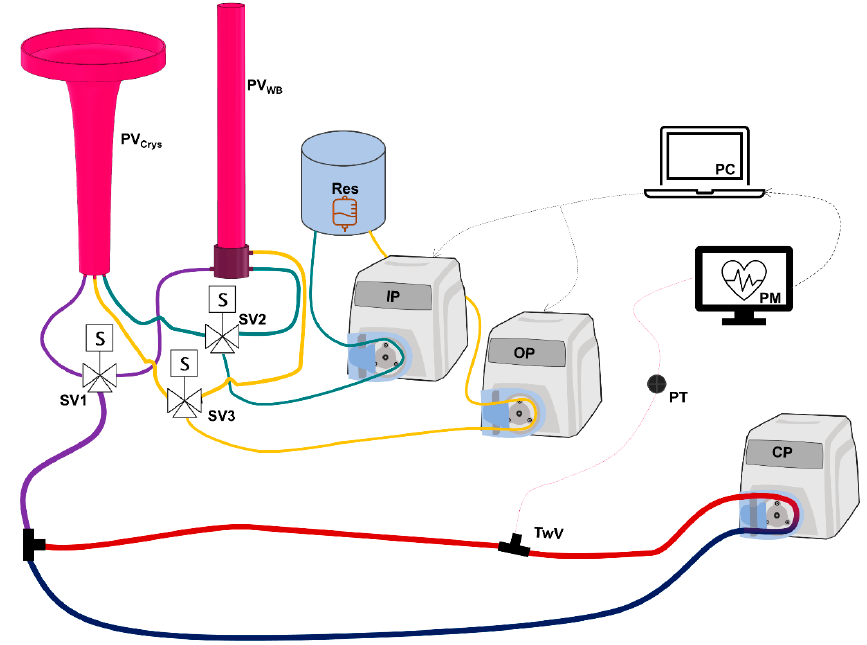
Figure 1. Diagram of HATRC Flow Loop . The arterial and venous side of the main circulatory flow loop are colored red and blue, respectively. Circulatory flow is supplied by a peristaltic pump (CP). Then, arterial pressure is measured by pressure transducer (PT) through fluidic connection at a three-way valve (TwV). Arterial waveform data are displayed with a patient monitor (PM) and recorded in real-time via computer (PC) running the hemorrhage scenarios and PID controllers. Static pressure is supplied to the loop via purple line from either whole blood (PV WB ) or crystalloid (PV Crys ) PhysioVessels based on position of solenoid valve (SV1). Infusion (IP) and outflow (OP) peristaltic pumps are supplied with water from an external reservoir (Res) and are connected via teal and yellow lines, respectively, to add or remove volume from the appropriate PhysioVessel based on position of SV2 and SV3. Both peristaltic pumps are fully controlled by the algorithm running on the